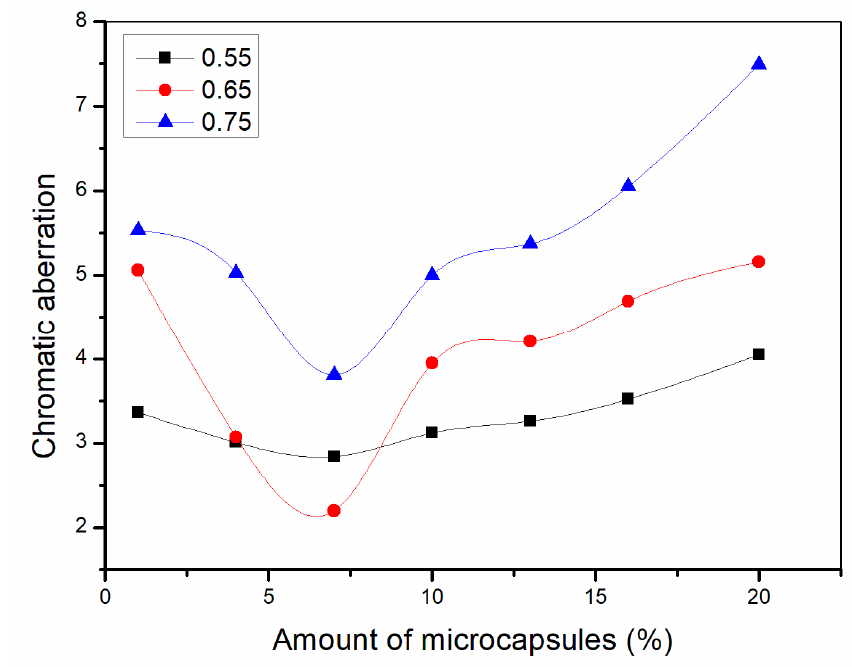
Figure 12. Chromatic aberration of the coating after drying at 120 °C for 2 h.